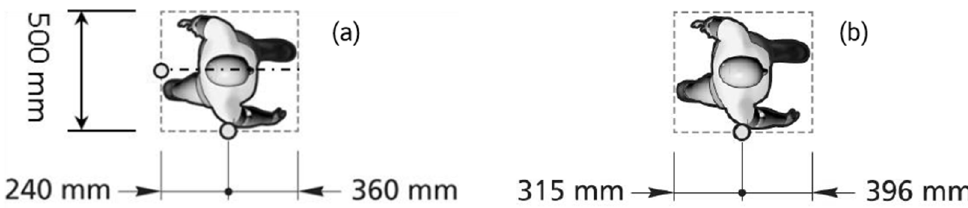
Figure 3. The bounding box for adult ( a ) and child pedestrian ( b ) dummy.